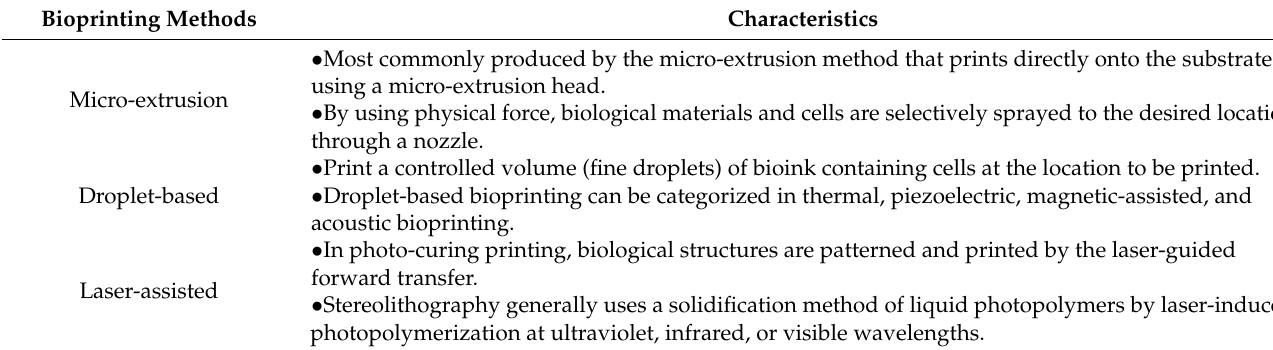
Table 2. Characteristics of various bioprinting